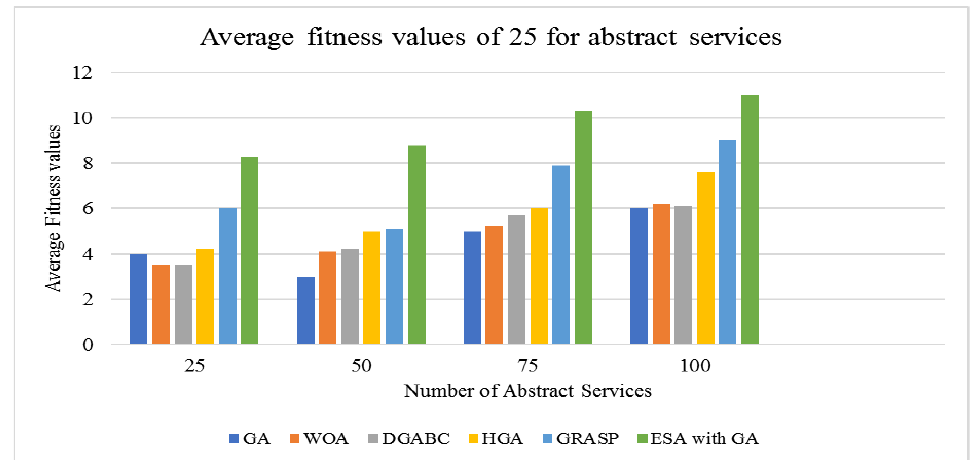
Figure 12. Best average fitness values for 25 abstract services.